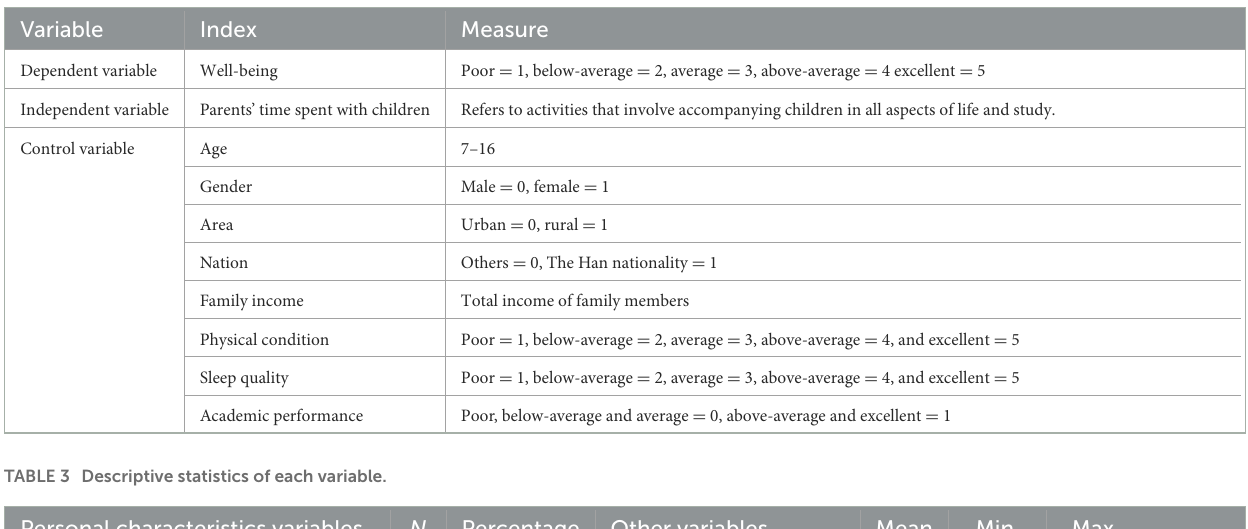
TABLE 2 Identification and specific operations of various variables.